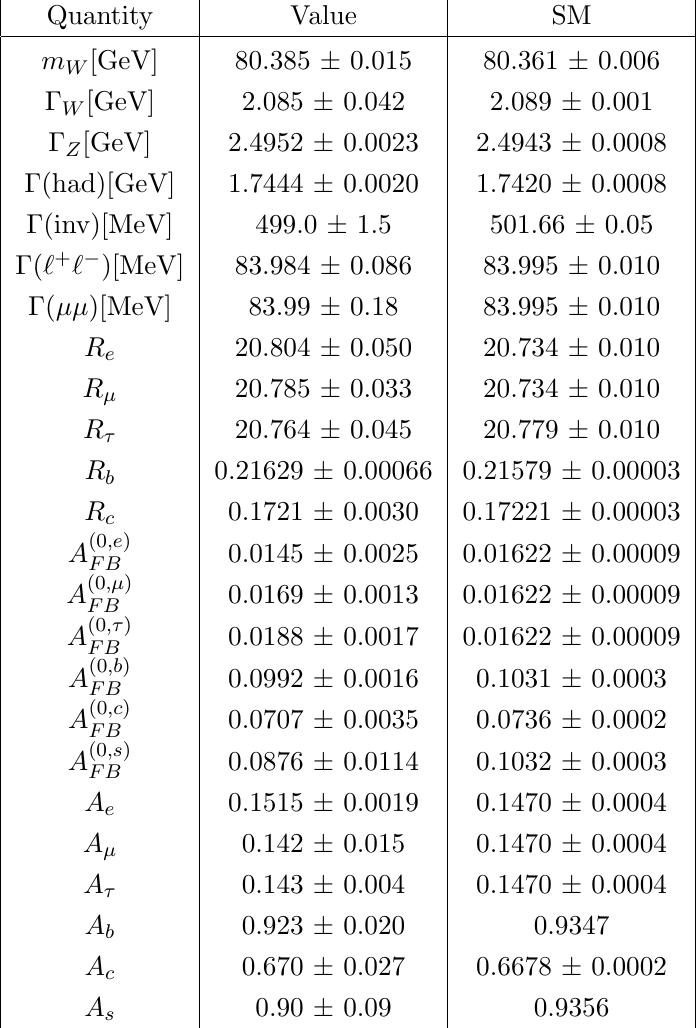
Table 4 . The electroweak precision data given by PDG